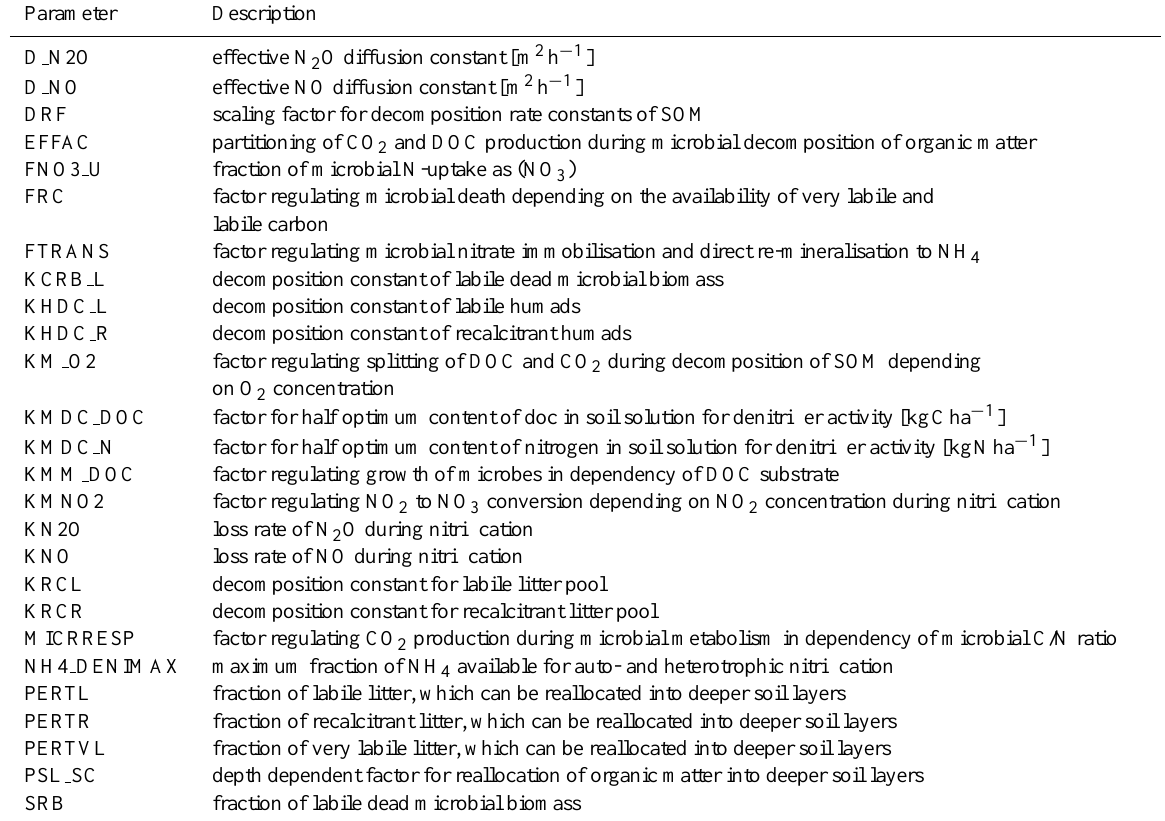
Table 1. Selected parameters being most influential for simulating soil-atmosphere trace gas fluxes (N 2 O, NO and CO 2 ) with LandscapeD-